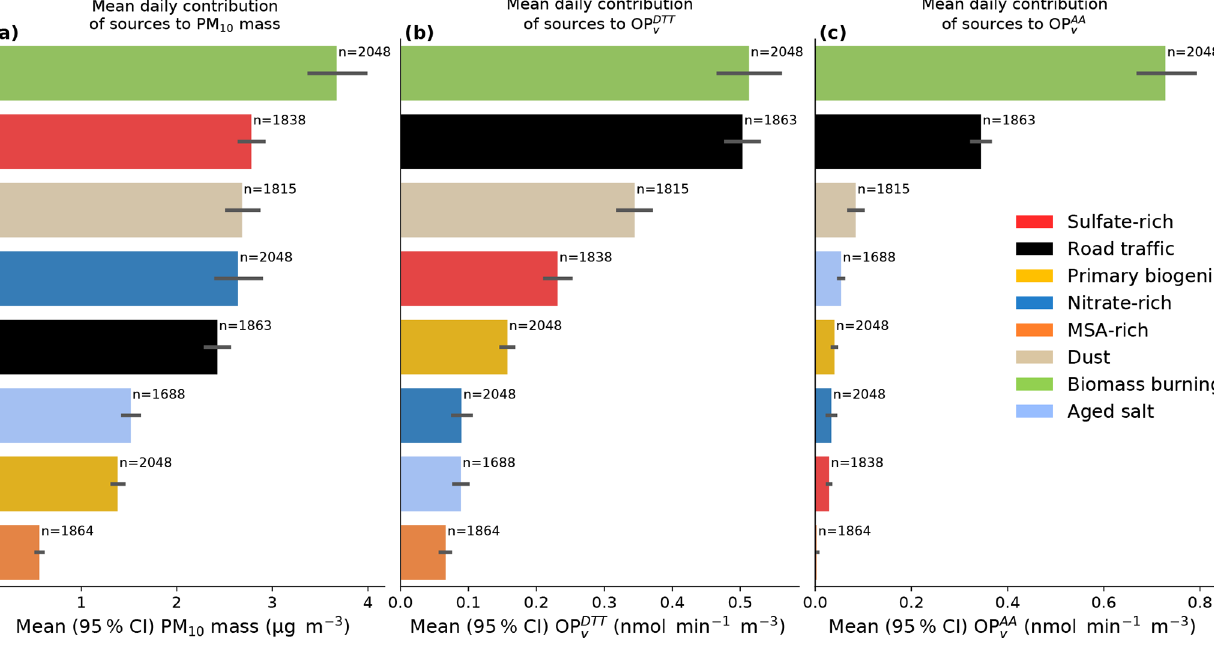
Figure 5. Averaged daily contribution of the sources to (a) the PM 10 mass, (b) the OP DTT v and (c) the OP AA v . The bars represent the mean, and the error bars represent the 95% confidence interval of the